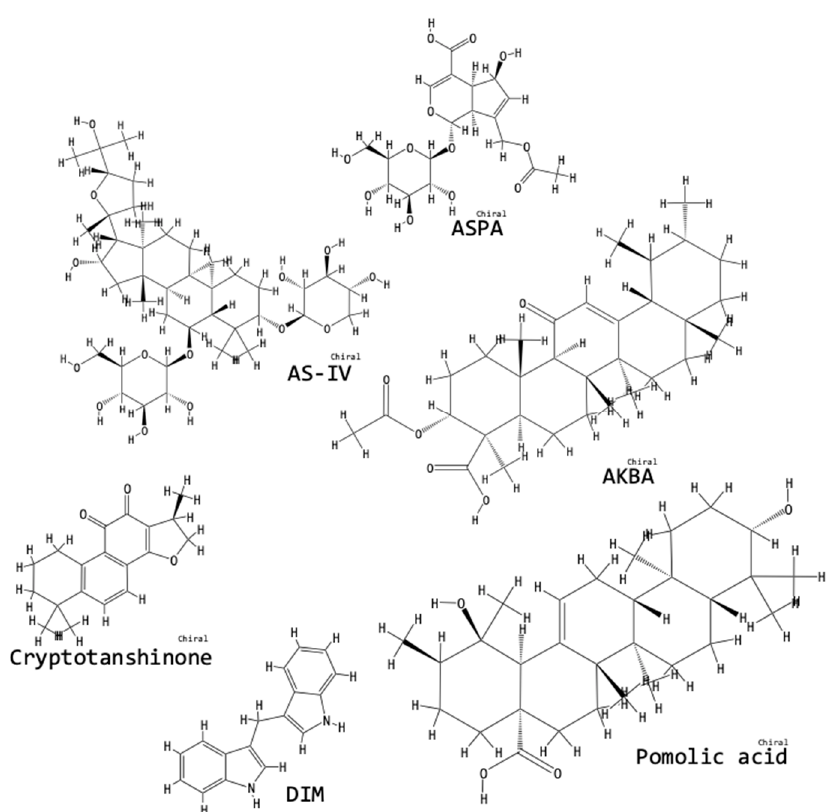
Figure 5. Chemical structures of plant-derived compounds tested for fibrosis-ameliorating activity in the context of the UUO model. The structures were obtained from the PubChem database [60]: the “PubChem CID” for each compound has been listed in the text next to the compound’s name.